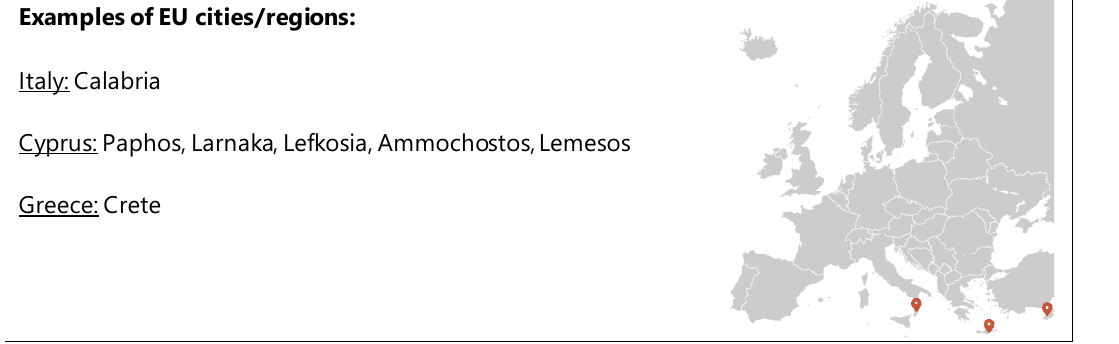
Figure 15. Retrofitting scenario 5: SCZ_G and RC_LSD_LEE.